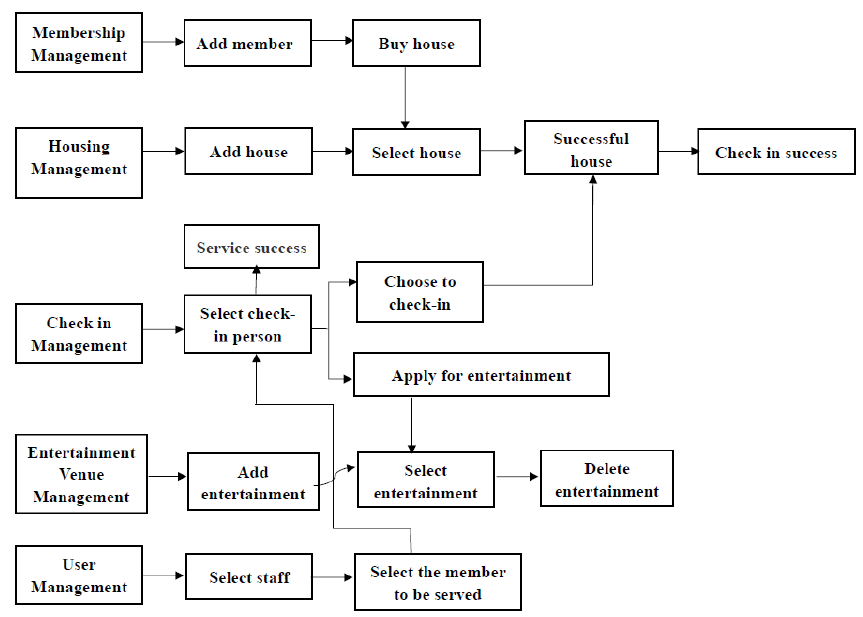
Fig. 1. Construction of the dynamic community management system for the